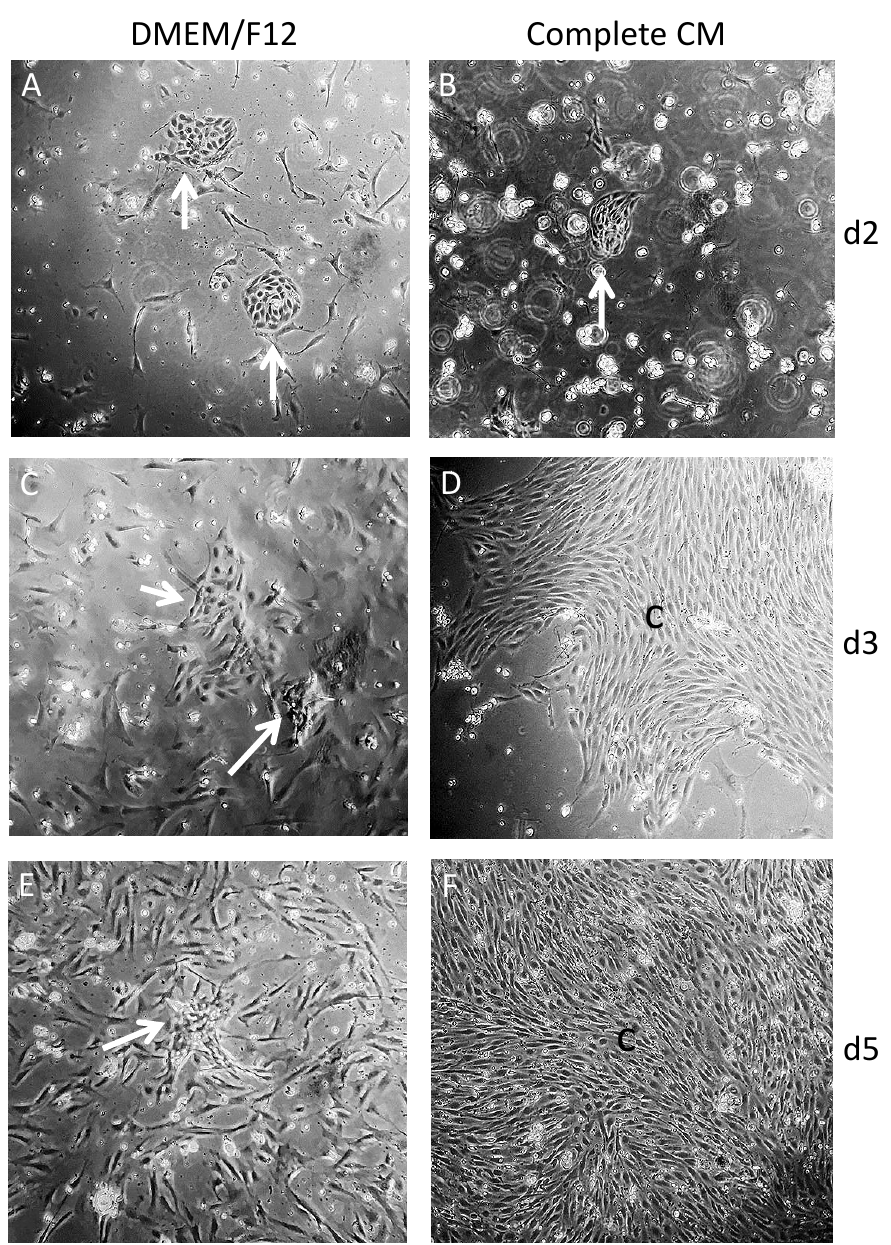
Figure 2. Comparison of freshly isolated SC clusters with complete CM ( B , D , F ) compared to complete DMEM/F12 ( A , C , E ) in collagen-coated flasks. At day 2 (d2), SC clusters generated with complete DMEM/F12 compared to complete CM demonstrated no significant differences in the numbers and sizes of patches ( A , B , arrows). However, a higher number of contaminating PCs/LCs is visible in complete DMEM/F12 ( A ) compared to complete CM ( B ), which seems to inhibit the growth of PCs. At day 3 (d3), SC clusters in complete CM formed larger clusters (c) with fewer contaminating PCs/LCs ( D ) compared to SC clusters in complete DMEM/F12 ( C ). At day 5 (d5), contaminating PCs/LCs had overgrown the SC colonies in complete DMEM/F12 ( E , arrow) in contrast to the confluent SC monolayer (c) in complete CM ( F ) (magnification ×